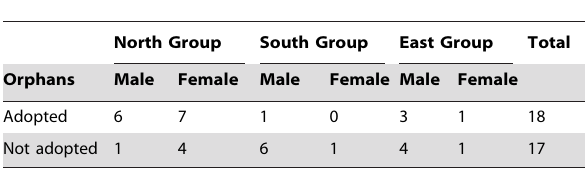
Table 2. Successful adoptions of orphaned infants in three communities of Taı¨ chimpanzees.